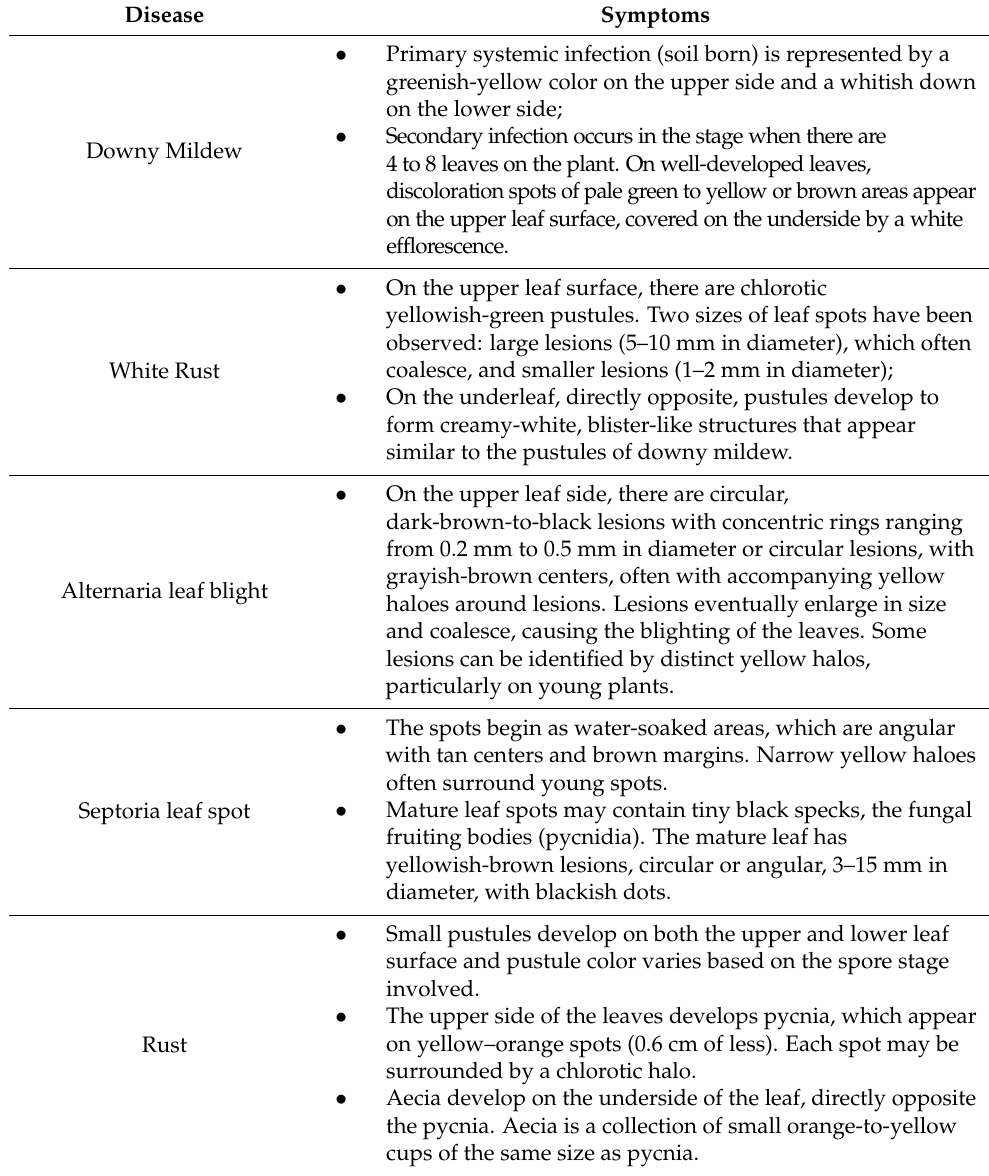
Table 1. Disease symptoms extracted from phytopathology books